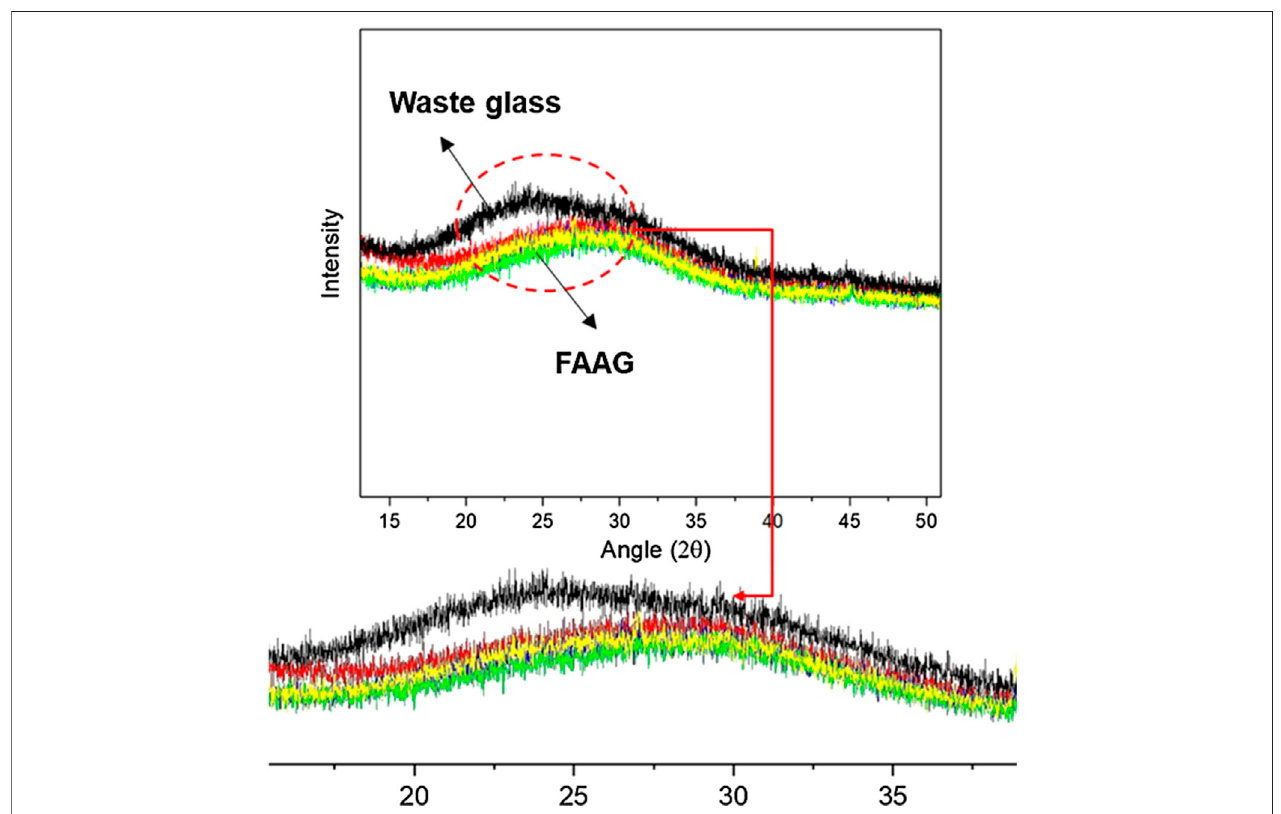
FIGURE10 | X-ray diffraction patterns ofraw milled waste glass (black line) and foamed alkali-activatedglass (FAAG) withdifferent amounts of foaming agent(red, yellow, and green line).